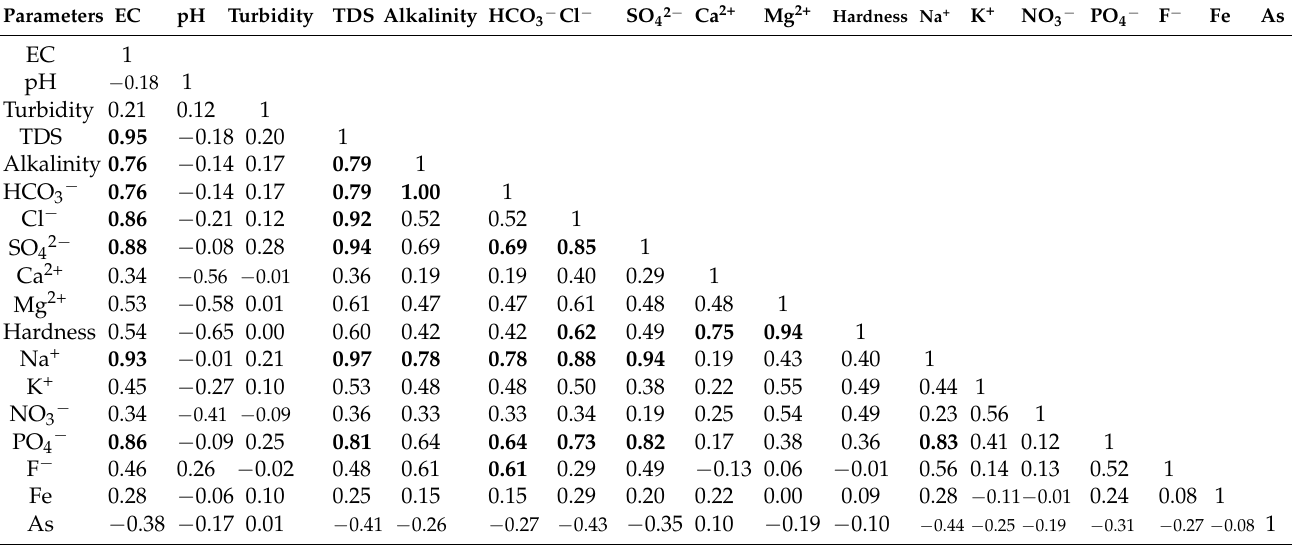
Table 2. Chemical composition of groundwater in the research area as determined using Pearson’s correlation matrix.